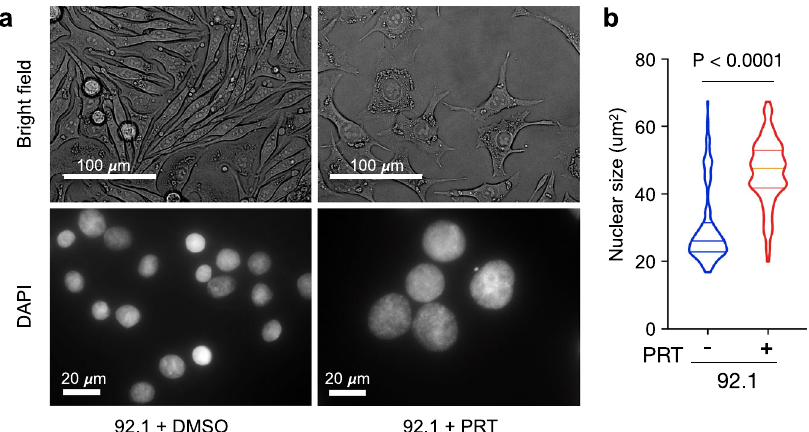
Fig. 4 Morphological changes and nuclear enlargement induced by PRC1 inhibition. a Top panel, bright fi eld light microscopy of low-risk UM cells (92.1) upon long-term DMSO and PRT-treatment. Bottom panel, DAPI staining of low-risk UM cells (92.1) after 48 h of PRT, and DMSO treatment. Images representative of experimental triplicates. b Violin plots showing the distribution of nuclei size in low-risk UM cells (92.1) upon PRT ( n = 152) and DMSO ( n = 163) treatment for 48 h. Lines distinguish interquartile ranges; width re fl ects observed nuclei number. Statistical signi fi cance tested using two-sided